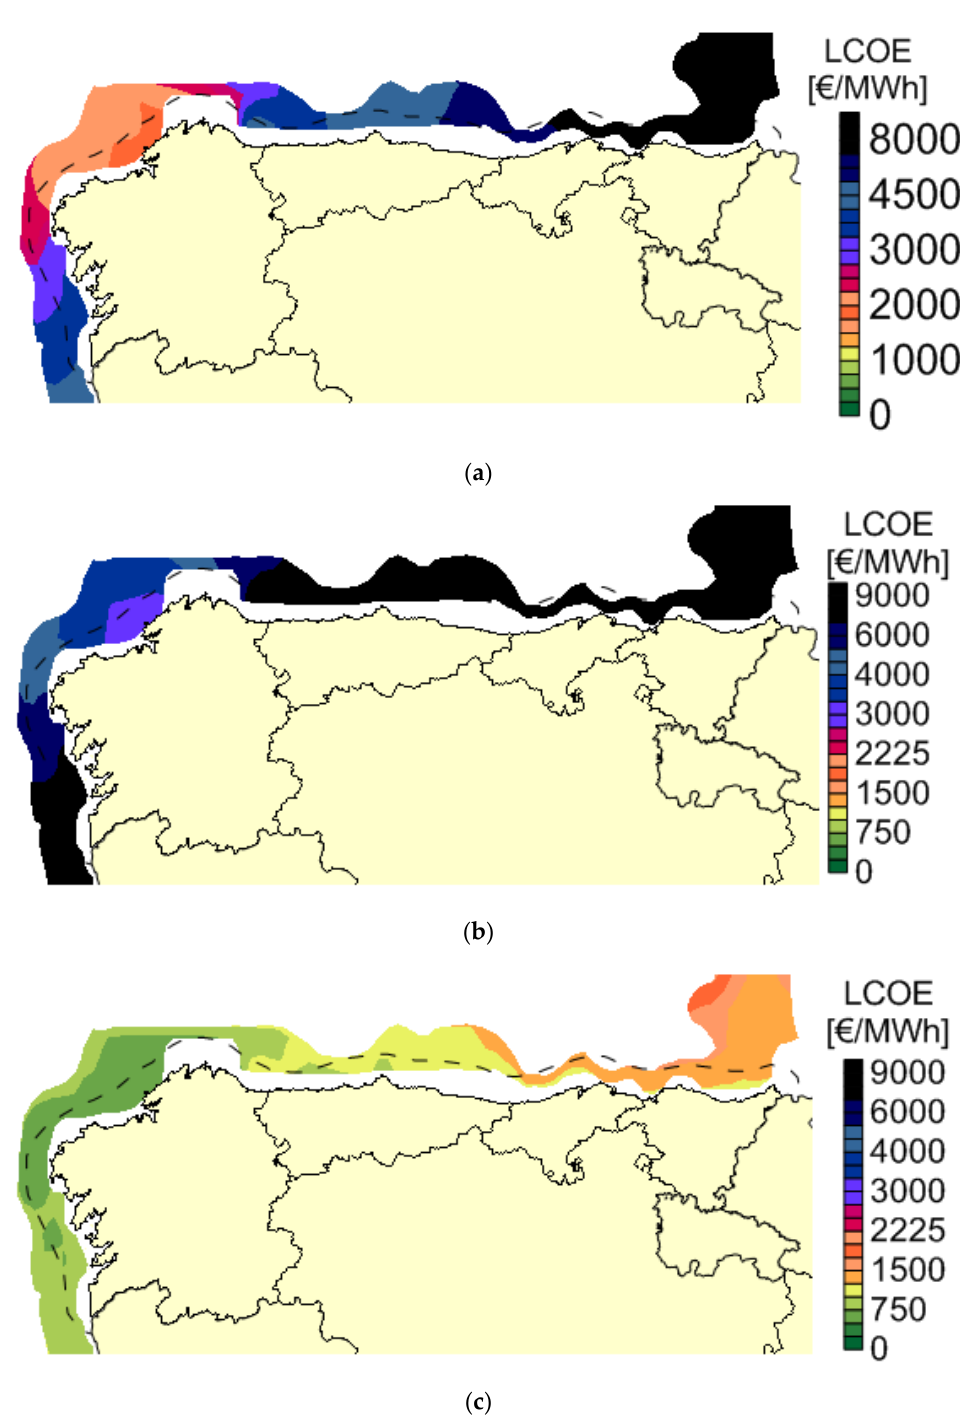
Figure 11. Levelized cost of energy with restrictions for D1 ( a ), D2 ( b ) and D3 ( c ).